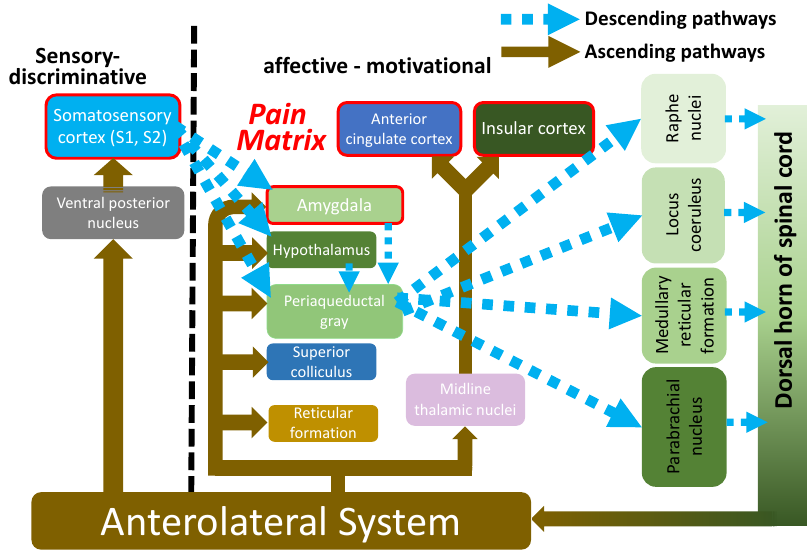
Figure 3. Pain matrix (adopted from Figures 10.5 and 10.8 (A) in [4]).